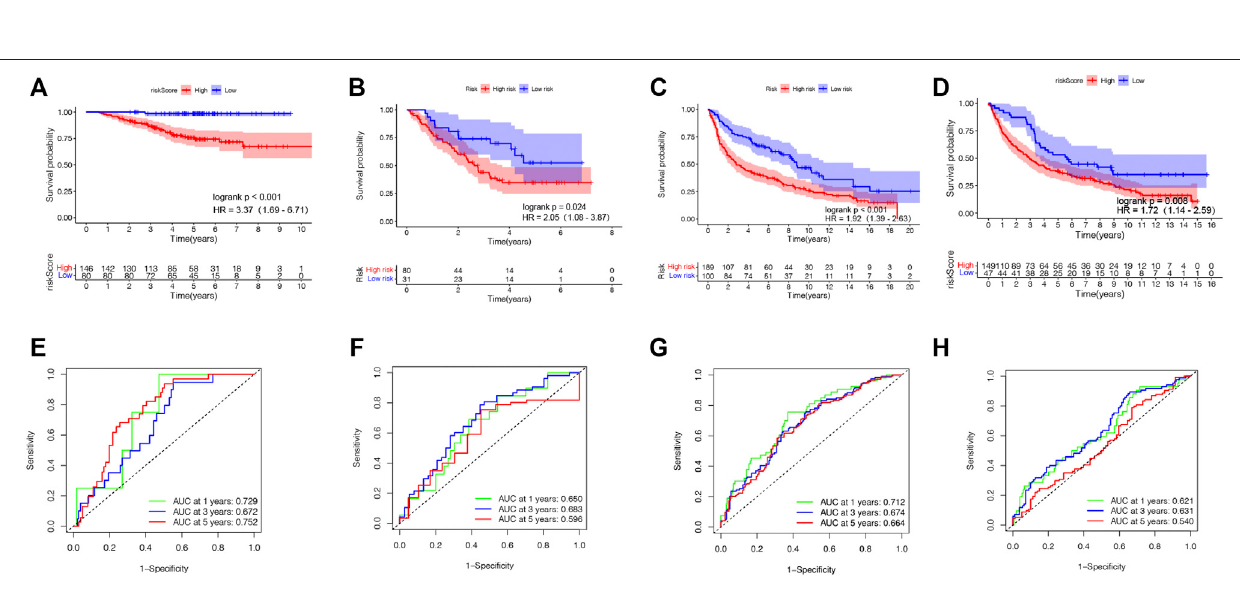
risk ” represented “ low TRIG score ” ; “ high